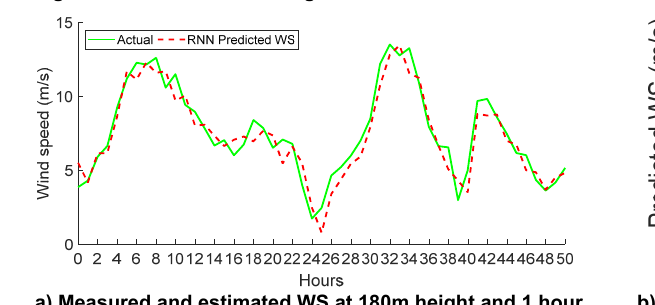
Figure 4. Performance at height 140m